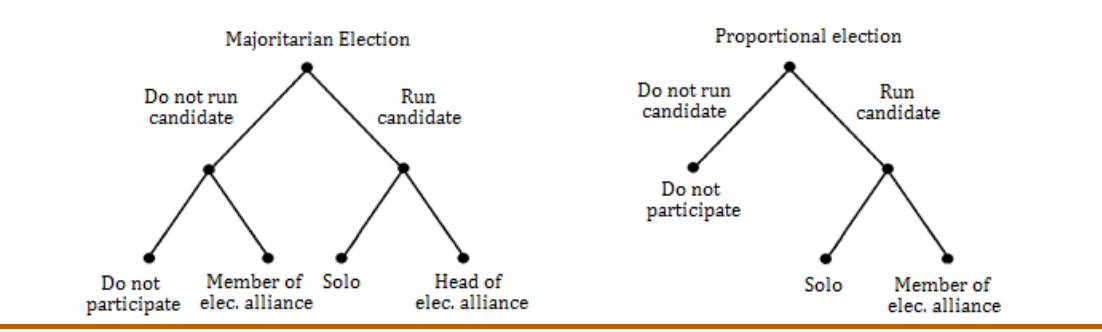
Graph 1. Decision trees for electoral entries and